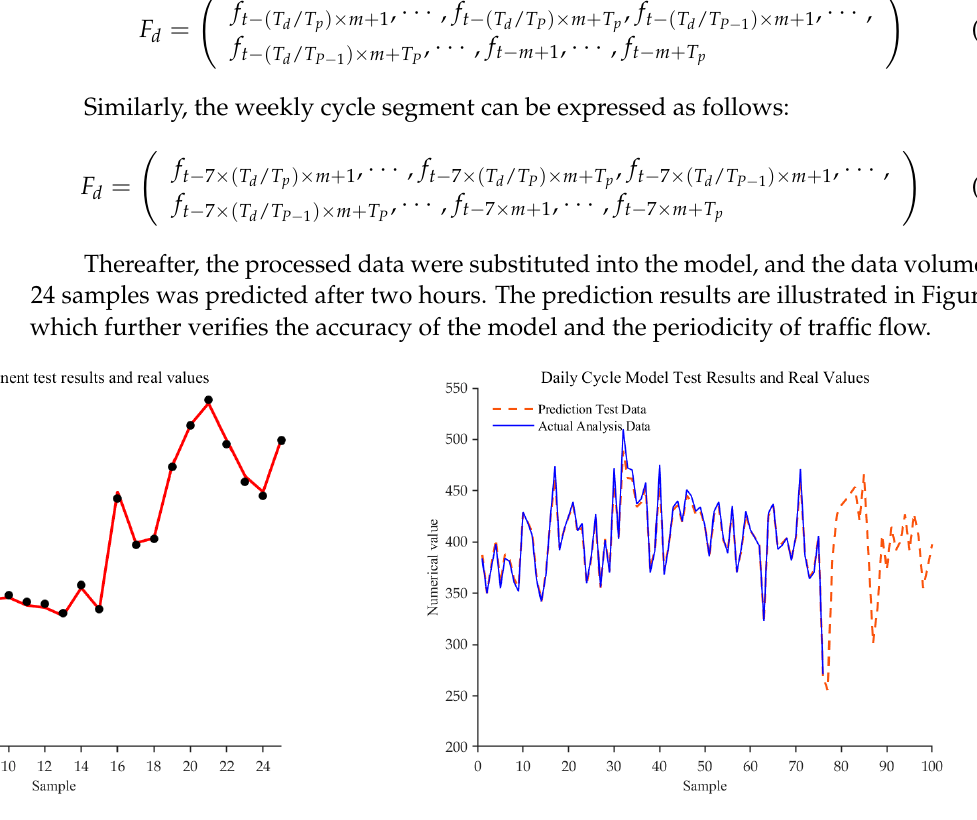
Figure 7. Weekly and daily forecasts.